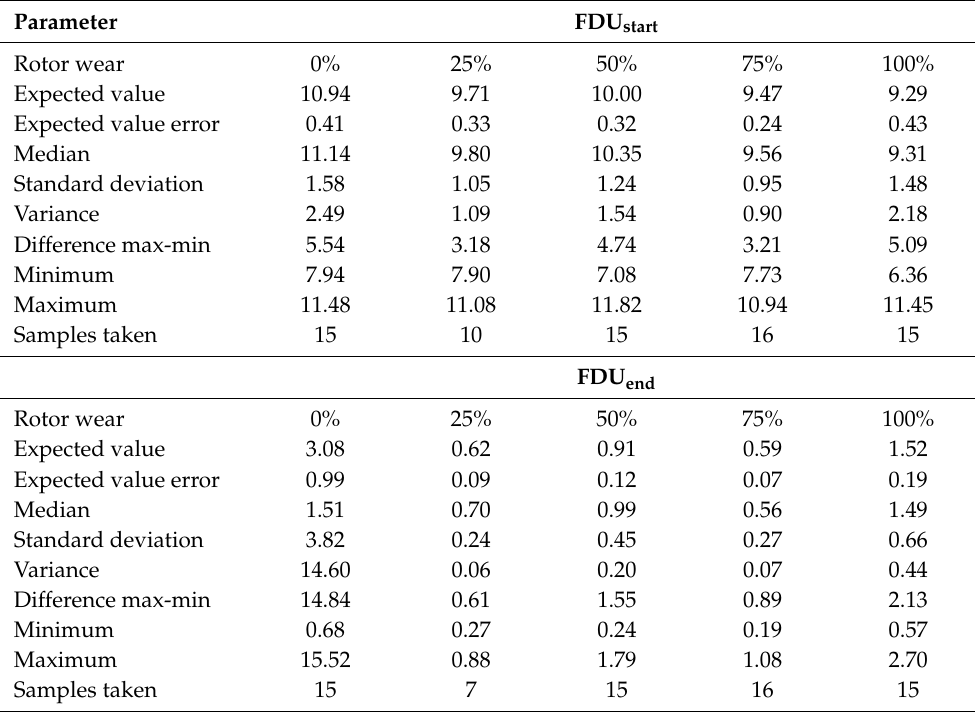
Table 12. Statistical summary of measure values of Dichte Index — type C rotor.